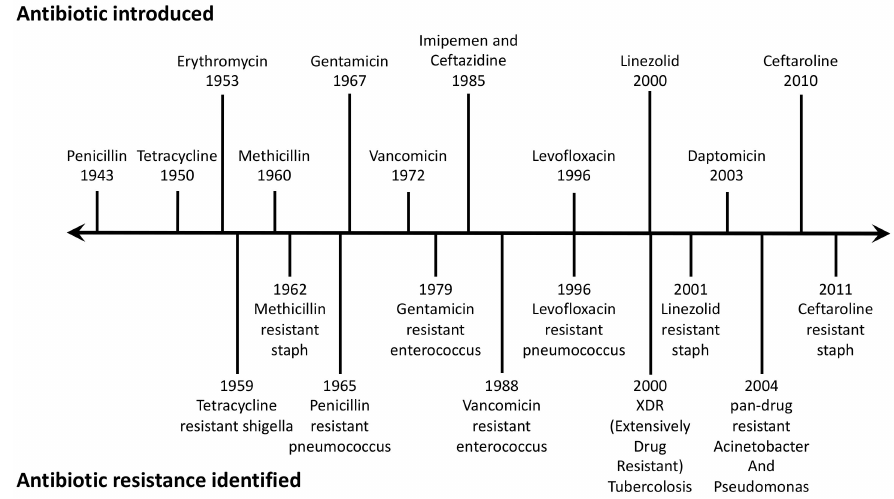
Figure 1. Antibiotic resistance pipeline. On the top, antibiotic introduced and, on the bottom, antibiotic resistance